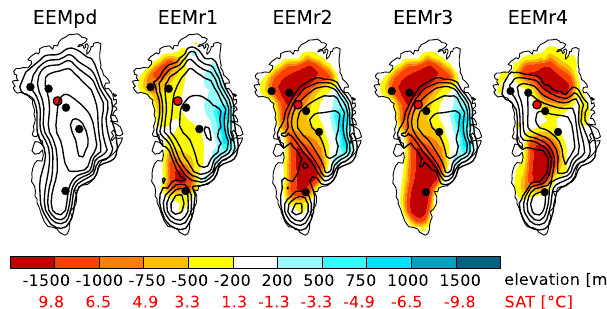
Figure 3. Greenland Ice Sheet topographies implemented in the Eemian sensitivity experiments. Elevation changes from the present-day mask (as used in EEMpd) are shaded (m) and the abso- lute surface elevation is shown in contour lines (contour interval is 500m). The red scale quantifies the equivalent SAT change in terms of lapse rate (+0.65 ◦ C per 100m decrease in surface